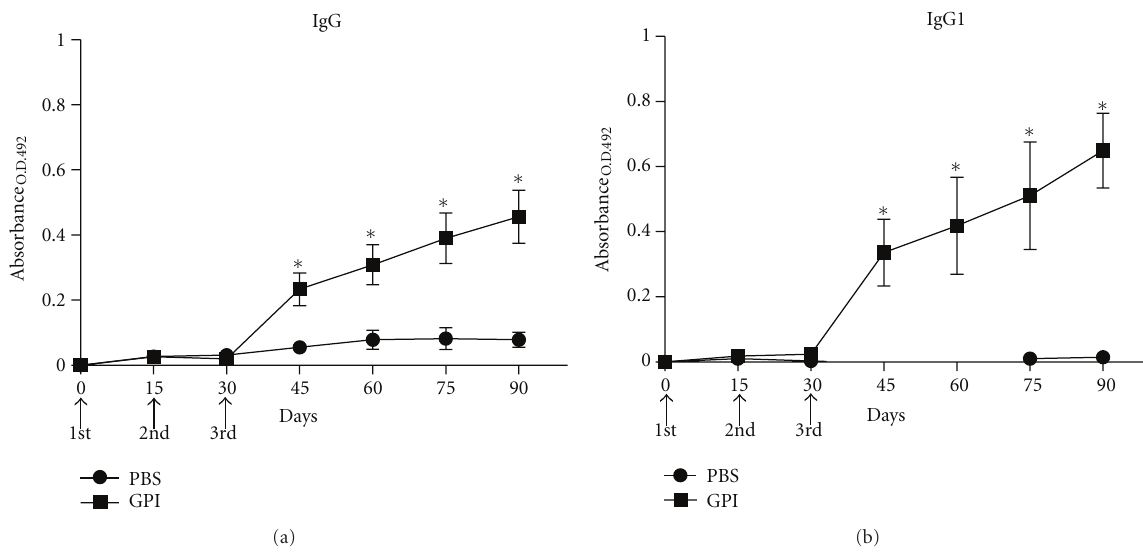
Figure 2: Kinetics of specific IgG and IgG1 anti-GPI-Proteins in sera of mice vaccinated with GPI-Proteins preparations. Sera of 10 immunized mice per group were collected prior first immunization and at days 15, 30, 45, 60, 75, and 90 after first immunization and assayed by ELISA for IgG (a) and IgG1 (b) antibodies. Control group was injected with PBS plus Freund adjuvant. Arrows indicate times of three immunizations. Results are presented as the mean absorbance measured at 492 nm for each group per day of sera collection. Asterisks indicate statistically significant di ff erences of vaccinated groups compared to control group ( P < 0 . 05). Results are representative of two independent biological